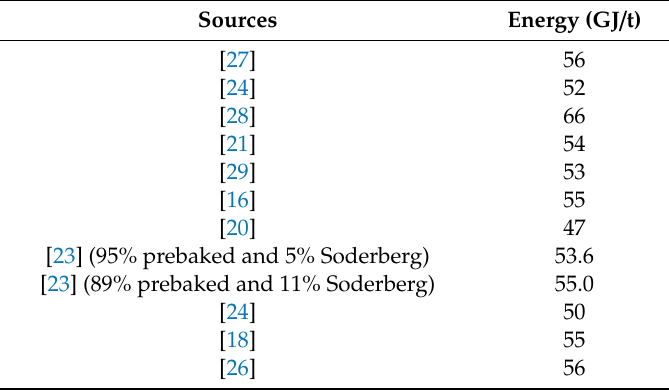
Table 3. Electrolysis energy per ton of